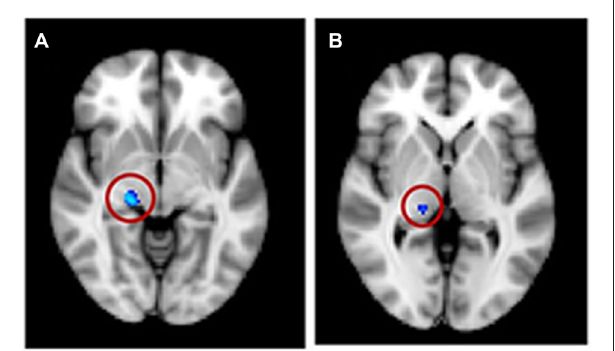
FIGURE 7 | Significant voxels (circled) found in the medial geniculate nucleus (MGN) for a reduction in white matter for tinnitus participants compared to controls for (A) regression group 1, all subjects and (B) regression group 2, severe tinnitus matched to